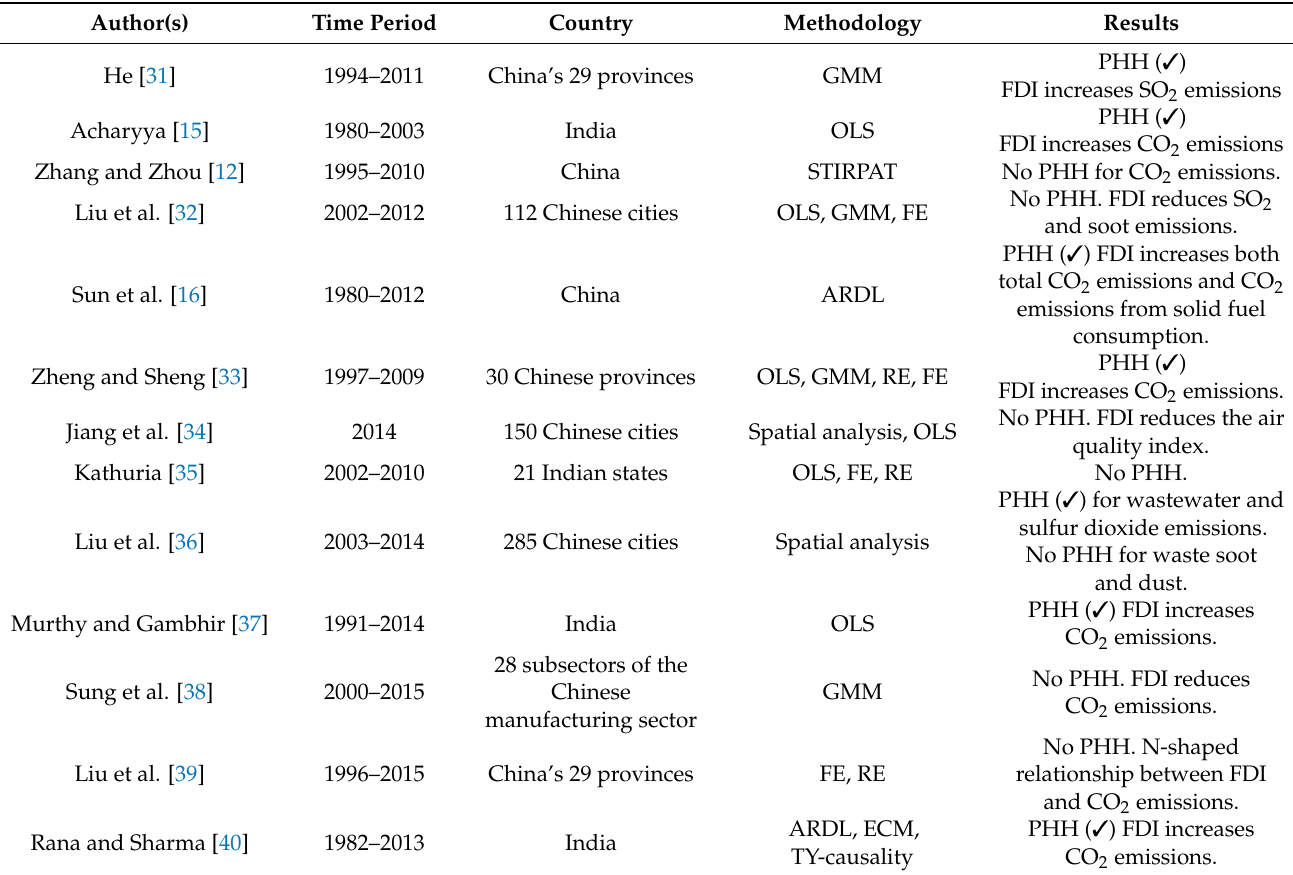
Table 1. Literature review on empirical findings of the PHH for China and